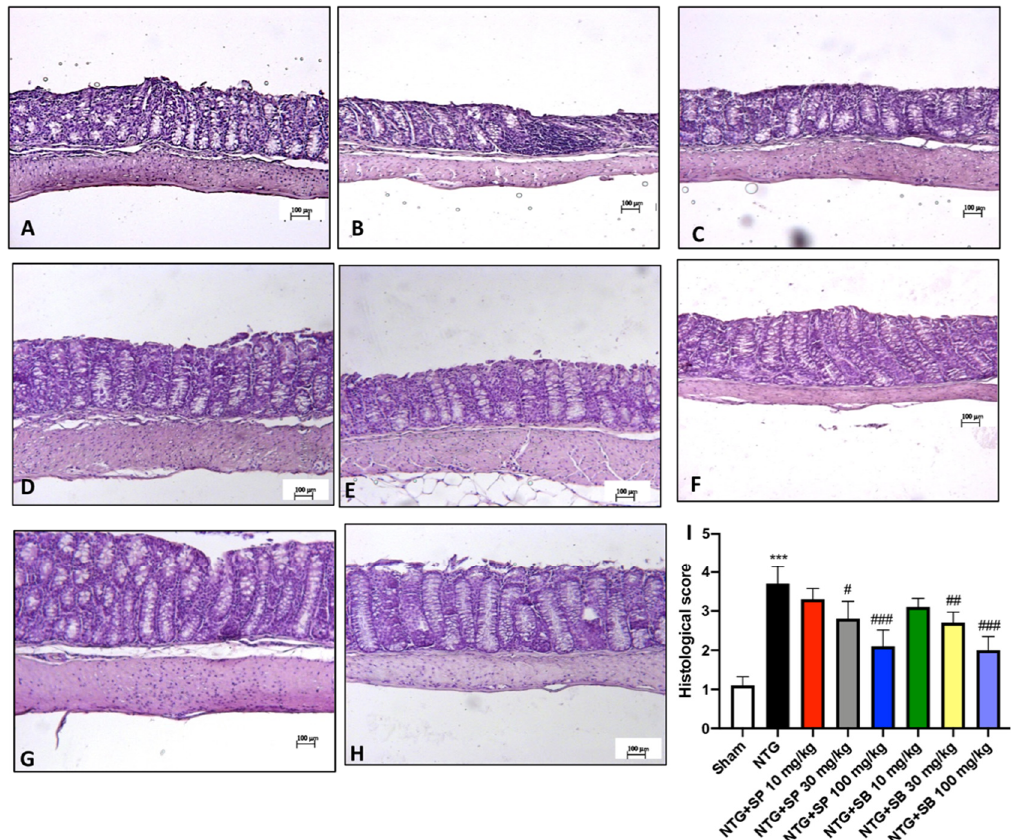
Figure 4. SCFA treatments attenuate intestinal alterations in NTG-injected mice. H&E staining shows an inflammatory condition in NTG animals ( B , I ) compared to the sham group ( A , I ). SCFA administration ( D , E , G , H , I ) at the highest doses effectively improves histological damage due to NTG injection. Treatments with SCFAs of 10 mg/kg are ineffective ( C , F , I ). Data are representative of at least three independent experiments; one-way ANOVA test. *** p < 0.001 vs. sham; # p < 0.05 vs. NTG; ## p < 0.01 vs. NTG; ### p < 0.001 vs. NTG. N = 10 mice/group for each technique.